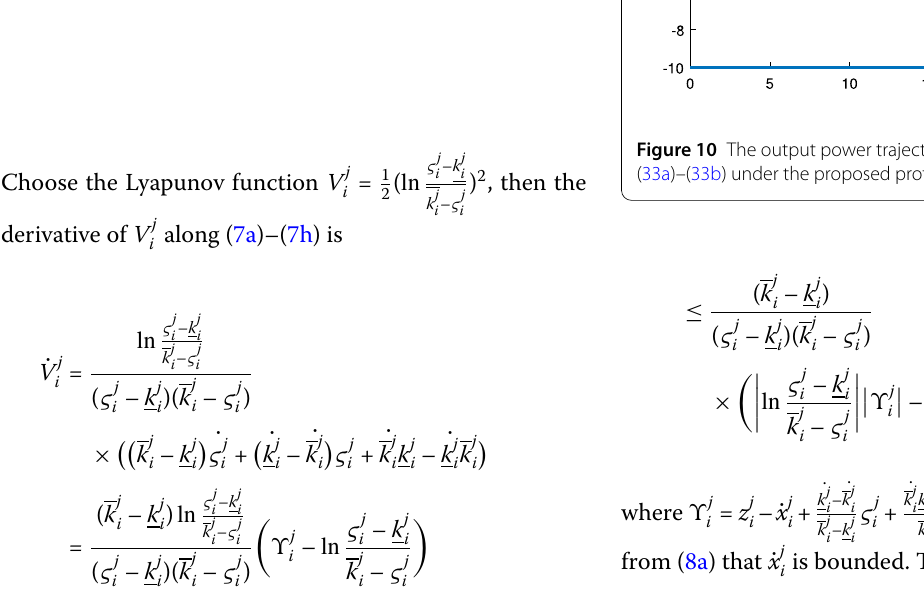
Figure 9 Unbalanced communication topology